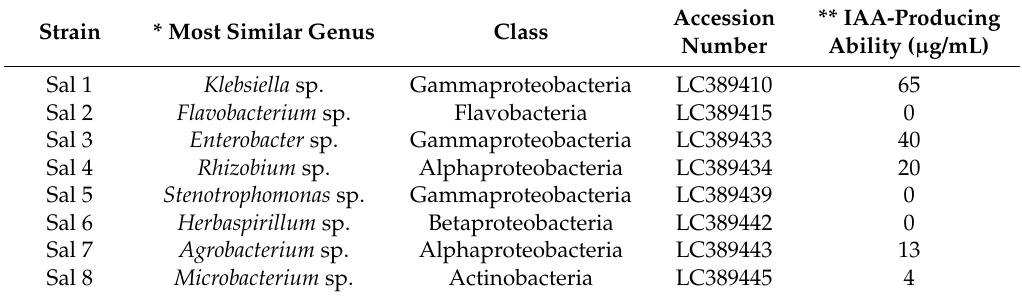
Table 1. Sweet potato endophytic bacterial strains used in this